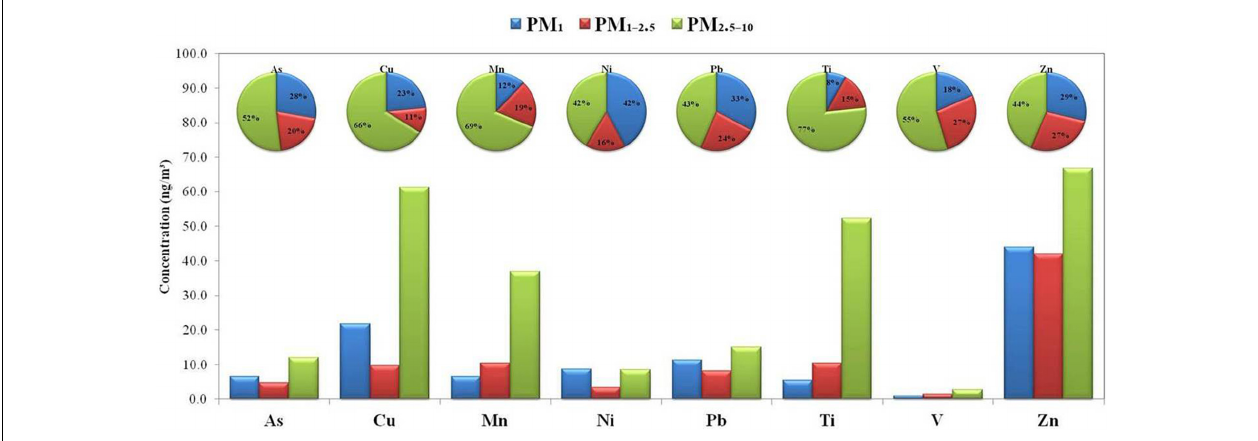
FIGURE 7 | Size distributions and contributions of the trace